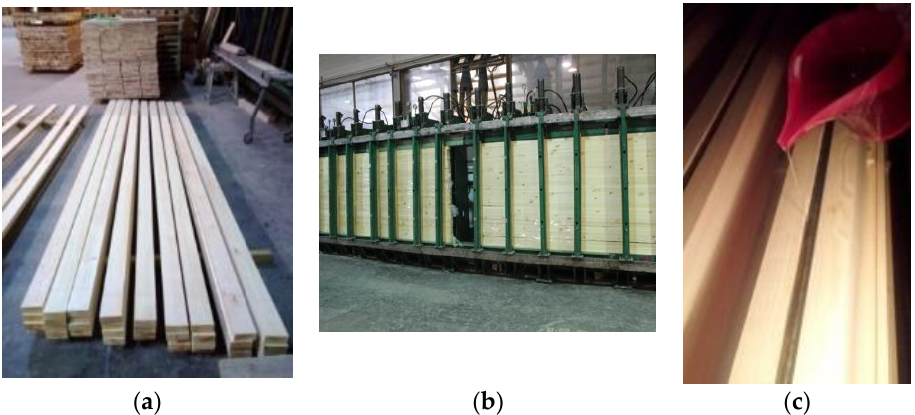
Figure 3. The preparation of the reinforcement of timber beams with BFRP bars: ( a ) strength classification of the sawn timber using a visual method; ( b ) gluing the lamellas together in a hydraulic glulam press; ( c ) application of epoxy resin into the milled grooves, followed by the insertion of basalt bars into the milled grooves and the preparation of pre-stressing. The initial pre-stressing force was 10 kN.